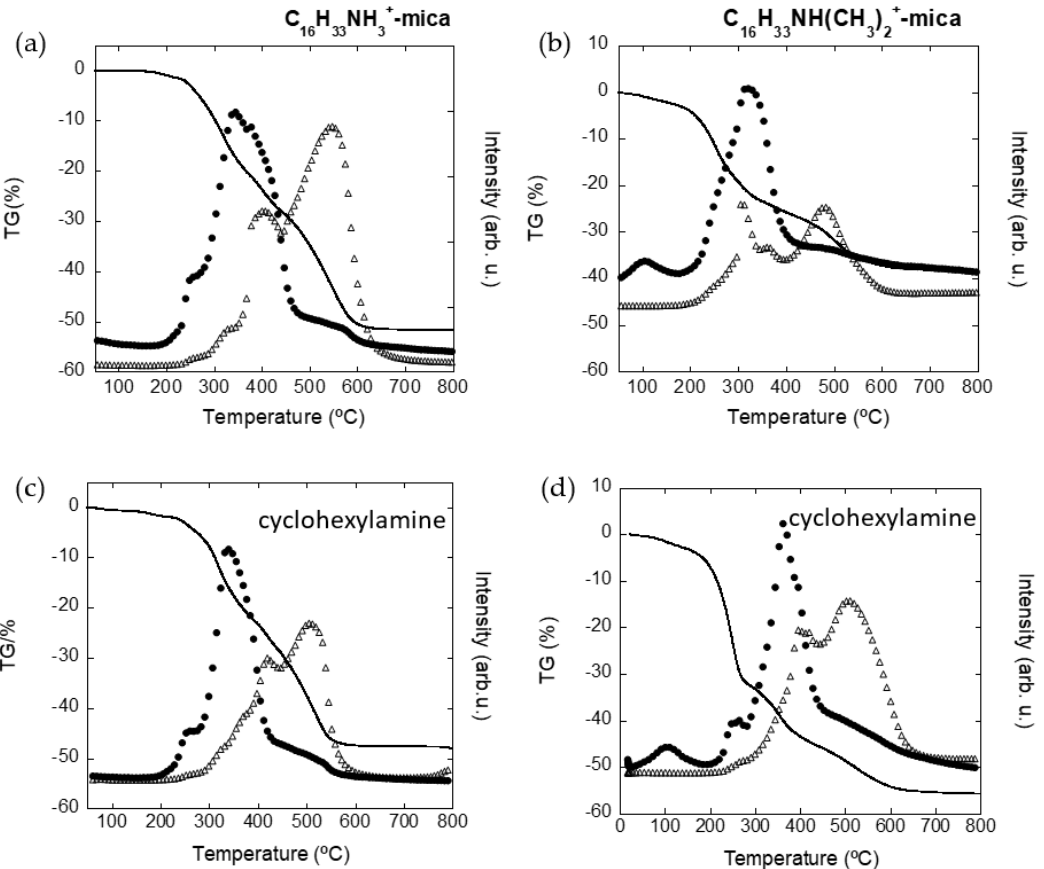
Figure 3. TG (solid line), MS H 2 O curves (black dots) and MS CO 2 curves (triangles) of C 16 H 33 NH 3+ -mica ( a ), C 16 H 33 NH(CH 3 ) 2+ -mica ( b ) and the samples after cyclohexylamine adsorption ( c ) and ( d ).